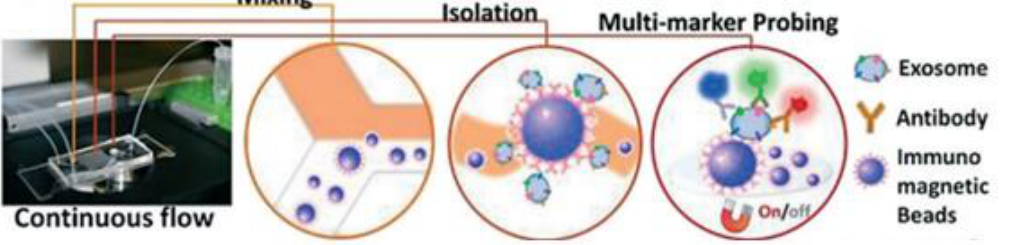
Figure 13. The setup and workflow of the ExoSearch chip for continuous mixing, isolation, and in situ, multiplexed detection of circulating exosomes. (Reproduced from Zhao Z. et al. [78]. Copyright 2016, Lab Chip).